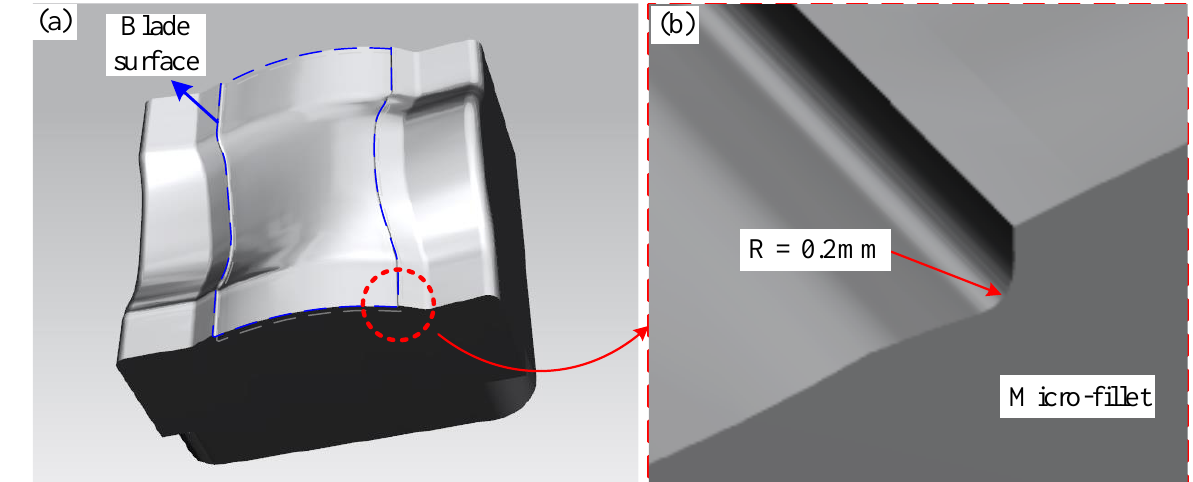
Figure 3. ( a ) Electrode of concave surface and ( b ) micro-fillet of blade electrode.